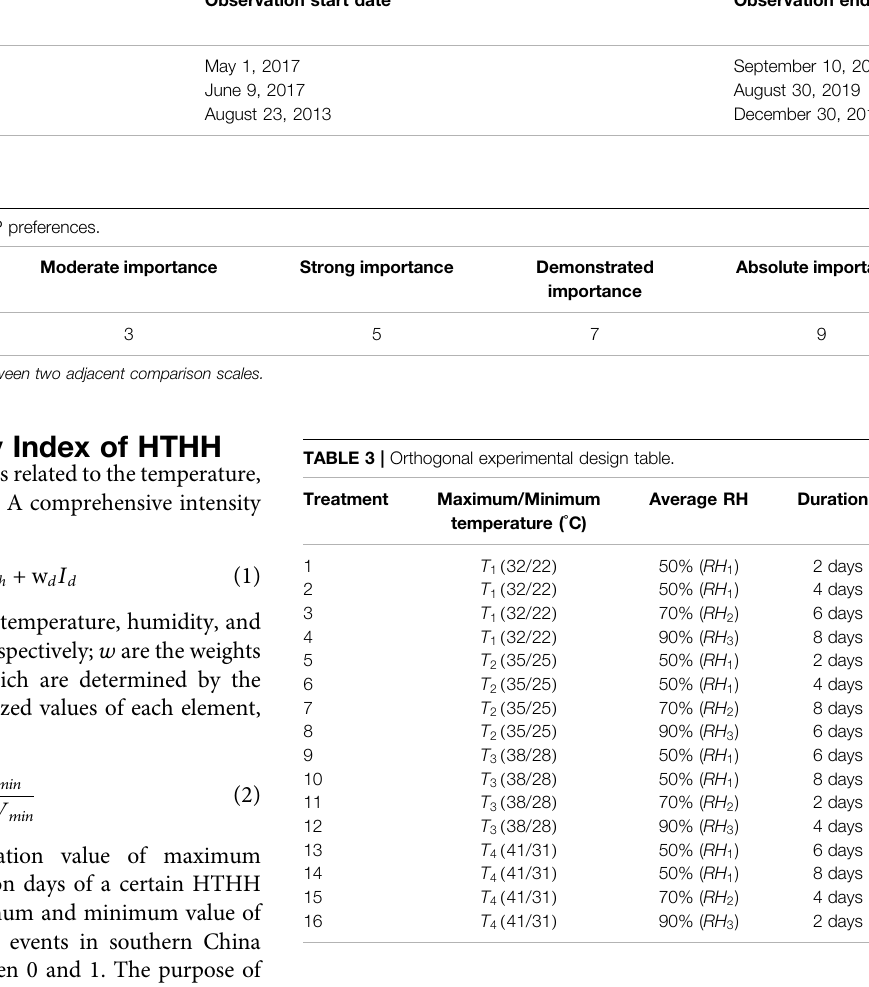
TABLE 1 | The locations of the plastic greenhouses and the periods of observation. Location (latitude, longitude)